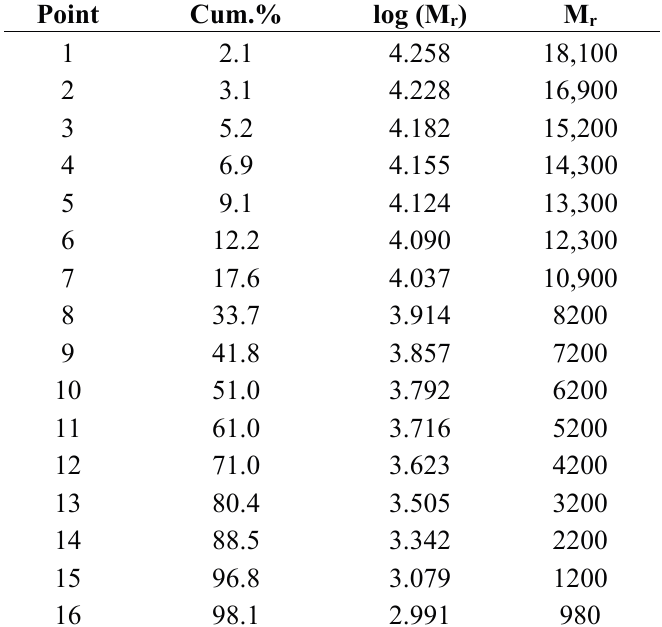
Figure 1. Curve of molecular weight distribution of partially depolymerized heparin ( γ -hep) together with the cumulative distribution function, generated by HP-SEC/TDA method. Table 1. Broad calibration table of a partially depolymerised heparin mixture, obtained by controlled γ -ray irradiation treatment of a pig mucosal heparin ( γ -Hep). Point